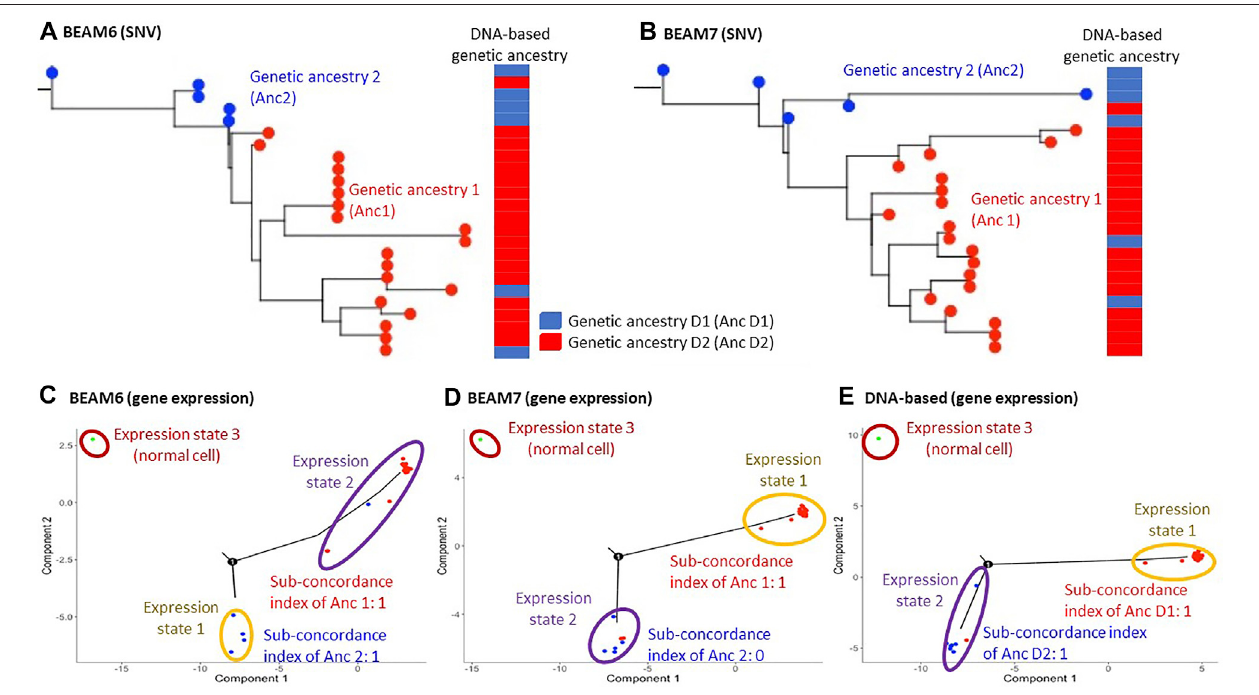
FIGURE2| Houdata analysis. (A,B) Inferred phylogenies on datasets where 60% (A) and 70% (B) SNV fi lteringcutoffswereapplied. BEAMwasused forbuilding cellular phylogeny to account for missing data and mutation calling errors. The genetic ancestry annotation obtained from the analysis of DNA data is shown next to the phylogenies.TheDNA-basedannotationwasobtainedfromHouetal.(2016). (C – E) Theinferredexpressiontrajectoryusinggeneticancestriesannotatedonthedataset with60%SNV fi lteringcutoff tree (C) ,70%SNV fi lteringcutoff tree (D) ,and DNA-basedgenetic ancestryannotation (E) .1,000 mostdifferentiallyexpressed genes between the genetic ancestries were used in each